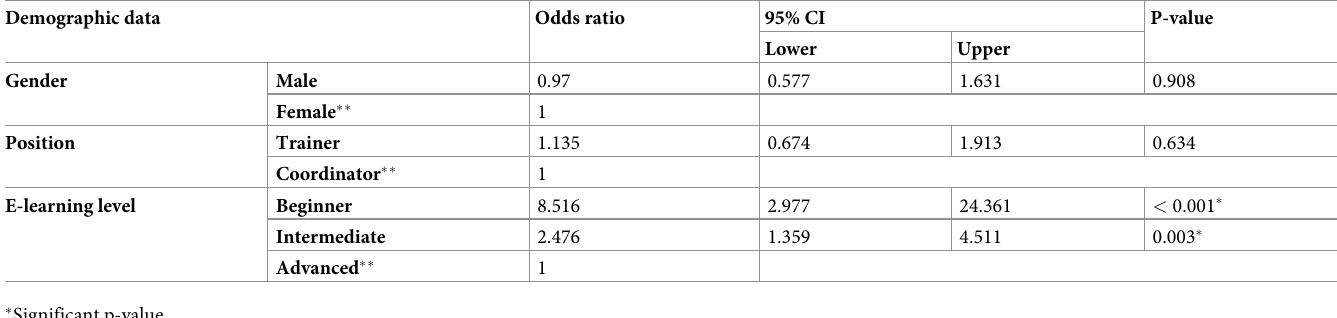
Table 5. Univariate logistic regression for factors associated with challenges to e-learning experienced by trainers and coordinators. Demographic